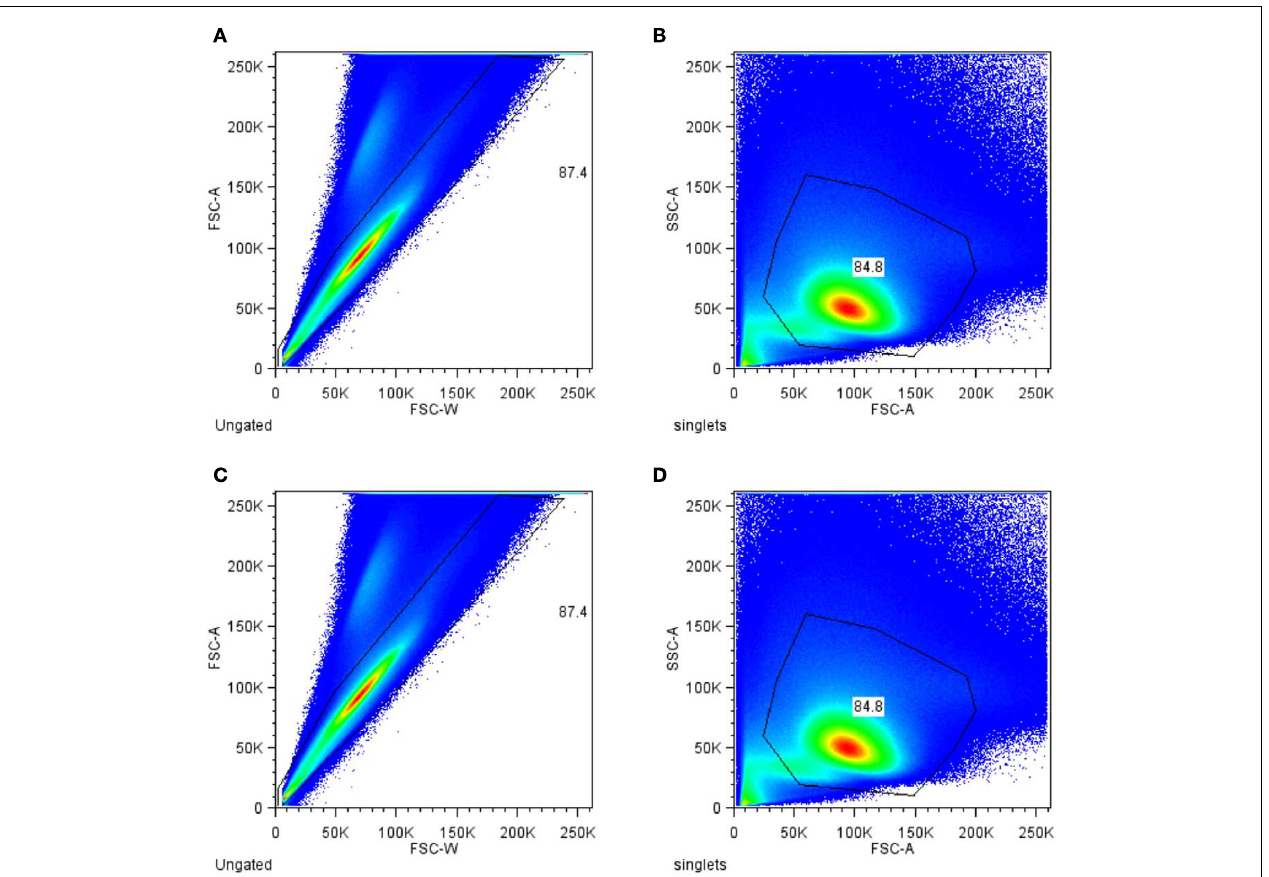
FIGURE 1 | Progressive filtering (gating) strategy for identification of antigen-specificT helper cells. Total events measured were filtered (gated) for single cell (A) and for lymphocytes (B) .To exclude dead cells aqua dye positive cells were excluded from further analysis (C) .The remaining cells were further selected for CD4 (D)